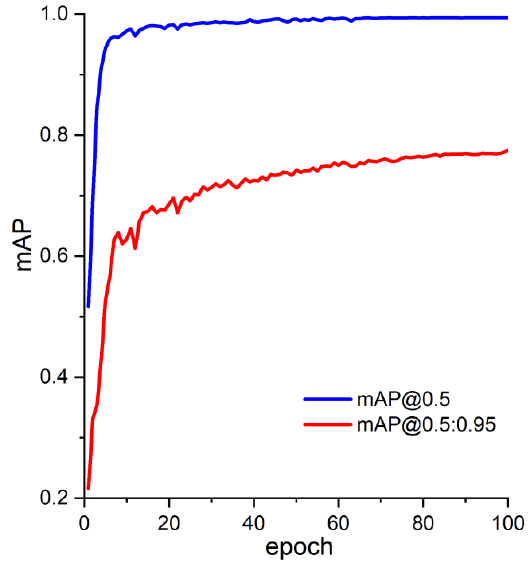
Figure 12. mAP curve.